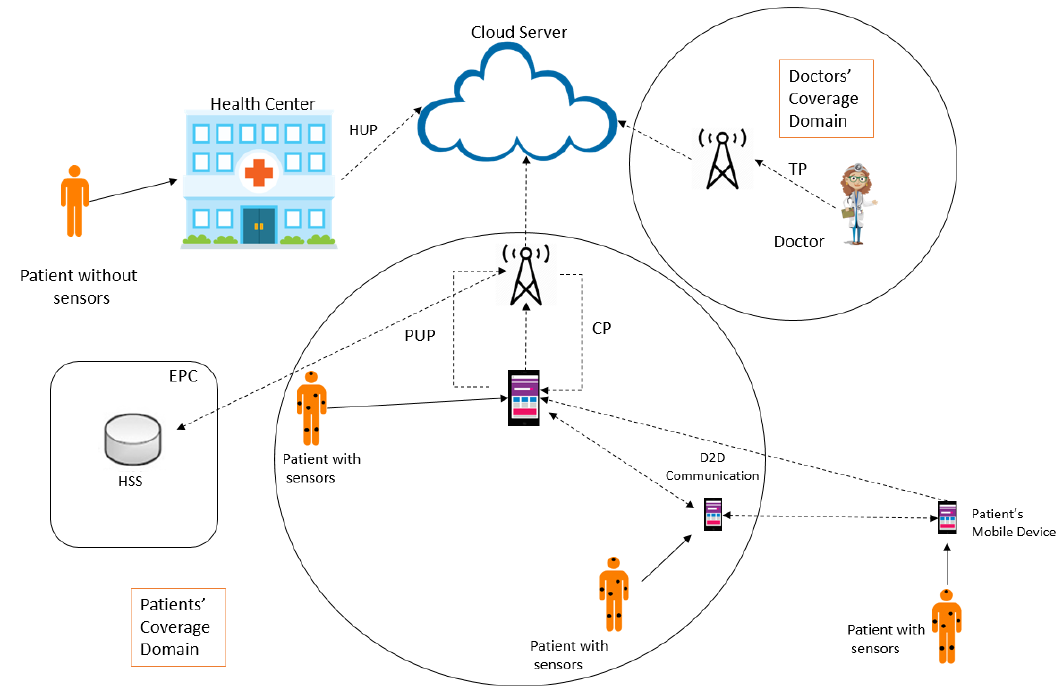
Figure 1. The architecture of the proposed scheme. Table 2. Notations used in the